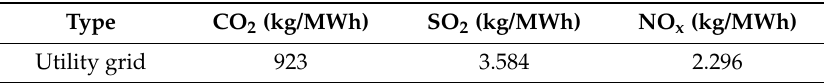
Table 9. Utility grid emission production rate per MWh.